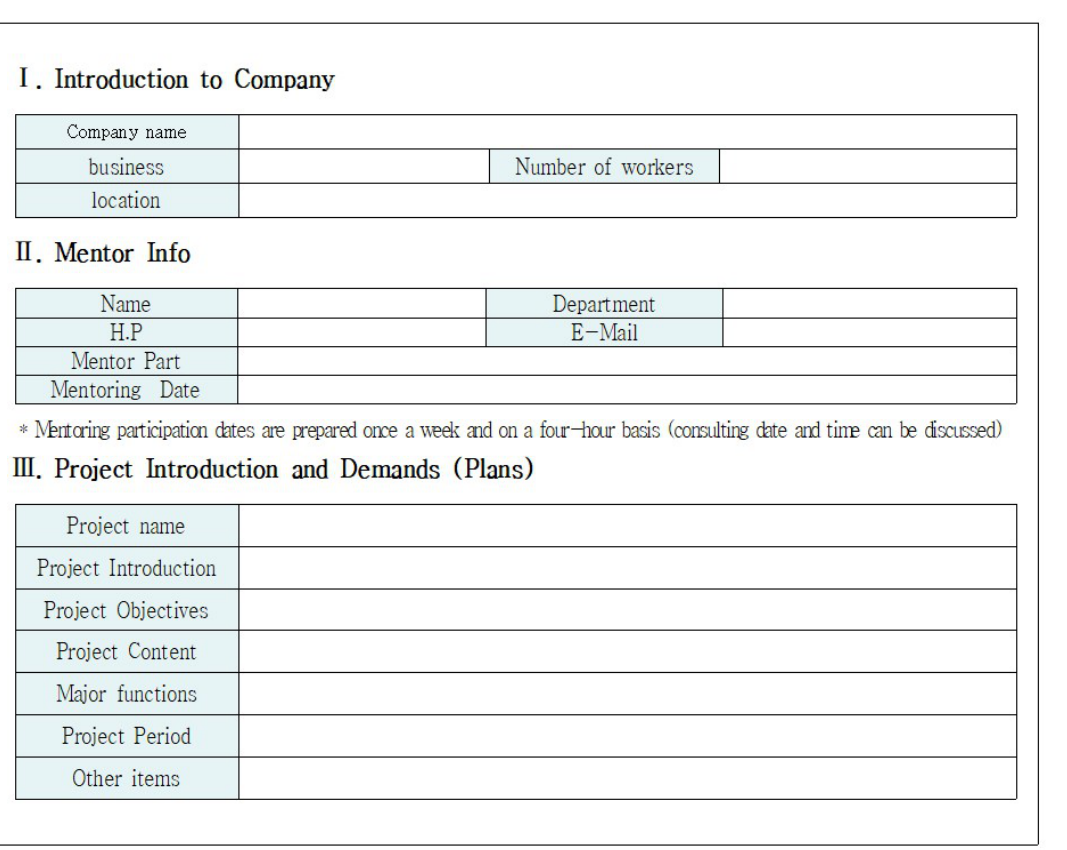
Figure 2. Industrial Project Requirements.